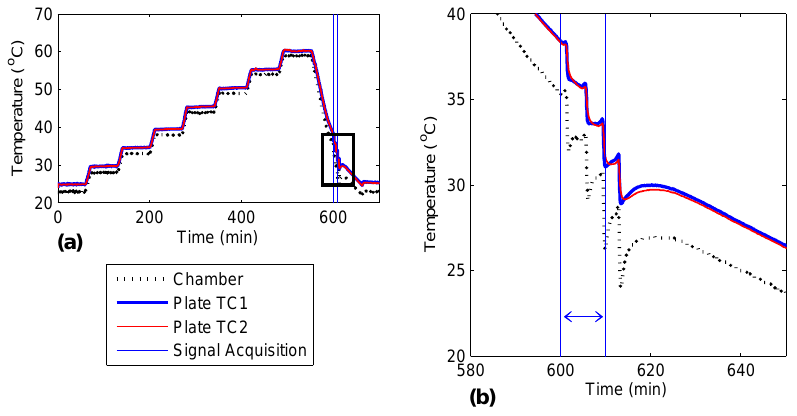
Figure 3. Rapidly decreasing temperature while the signal was recorded for the transient thermal tests. ( a ) Temperature profile for the chamber and two points on the plate (TC1 and TC2), ( b ) zoomed in temperature profile while signal was recorded.